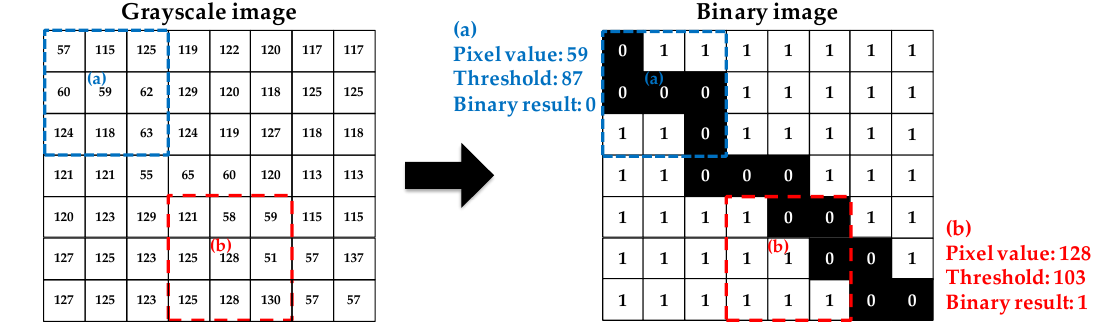
Figure 1. Demonstration of the binarization process in 3 × 3 windows (thresholds are determined simply using mean values) [32].